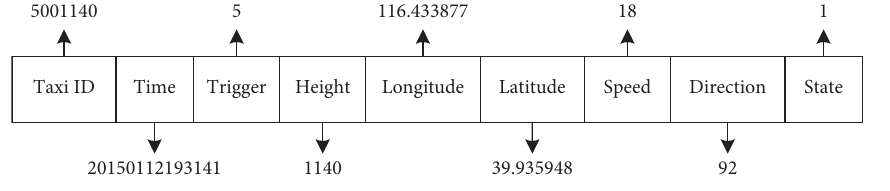
Figure 4: Sample of original GPS data.